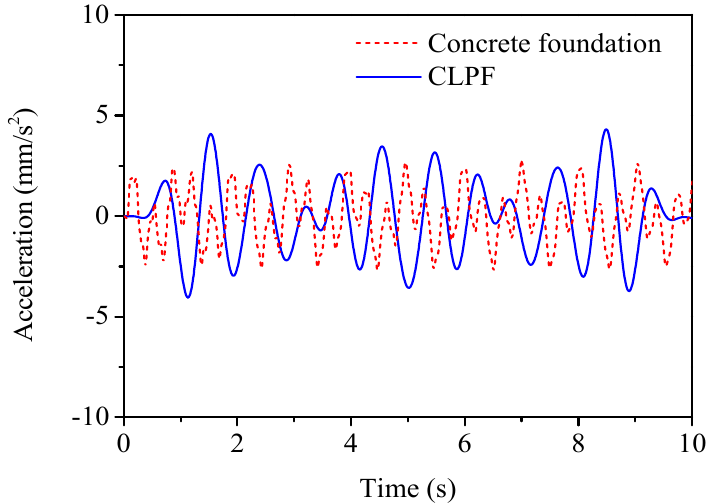
Figure 14. Acceleration responses of node P under harmonic excitation with frequency f = 2 Hz.